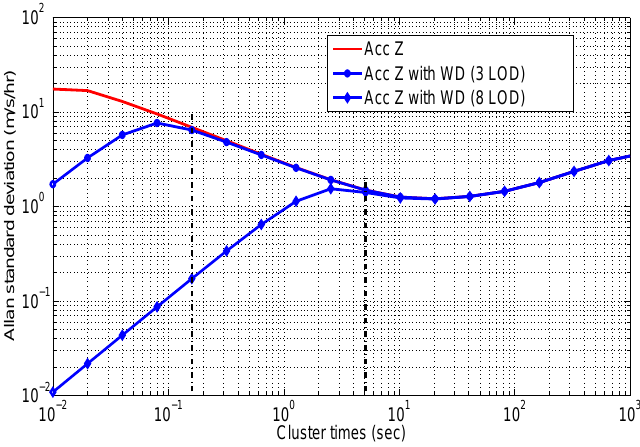
Allan variance accelerometer Z IMU 3DM-GX-25 after applying wavelet de-noising with three and eight levels of